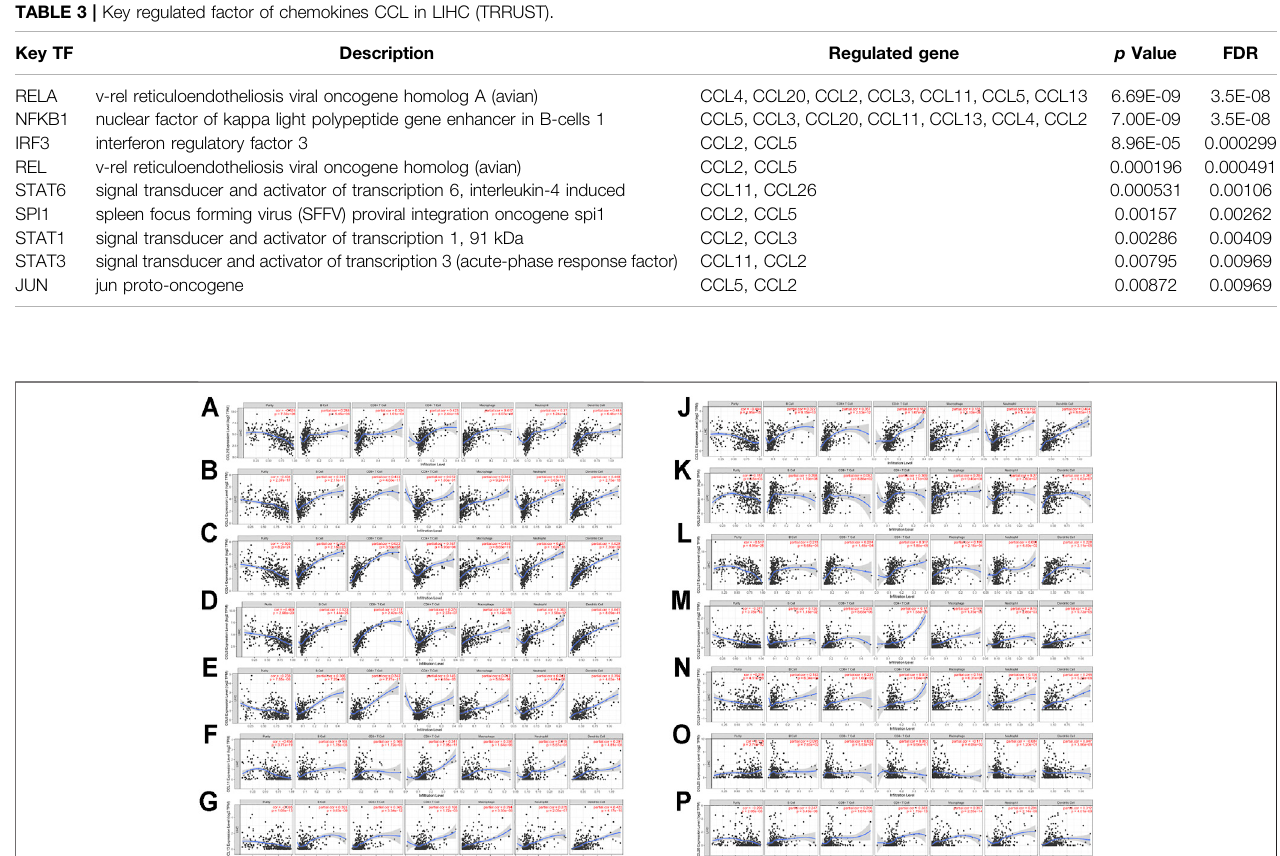
Frontiers in Cell and Developmental Biology |